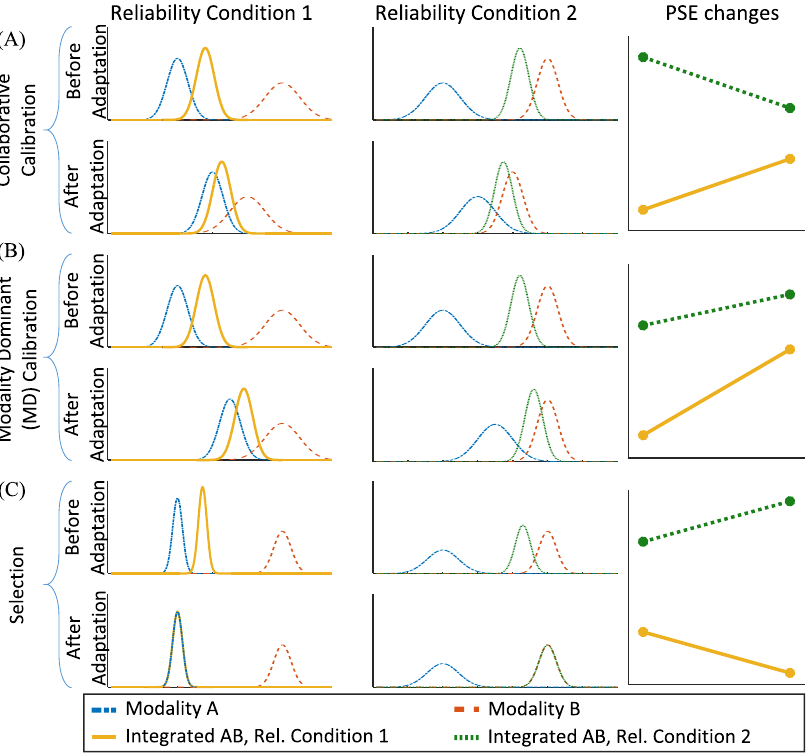
Figure 4. Simulation of different perception strategies in an environment of varying reliability. ( A ) stimulus S is perceived through two sensory modalities A (blue) and B (red) under two different reliability conditions. In the reliability condition 1, the reliability of modality A is higher than the reliability of modality ( B ) while it is vice versa in reliability condition 2. We simulated the variation of integrated PSEs in different adaptation strategies: ( A ) Collaborative calibration, ( B ) Modality Dominant (MD) calibration, and ( C )